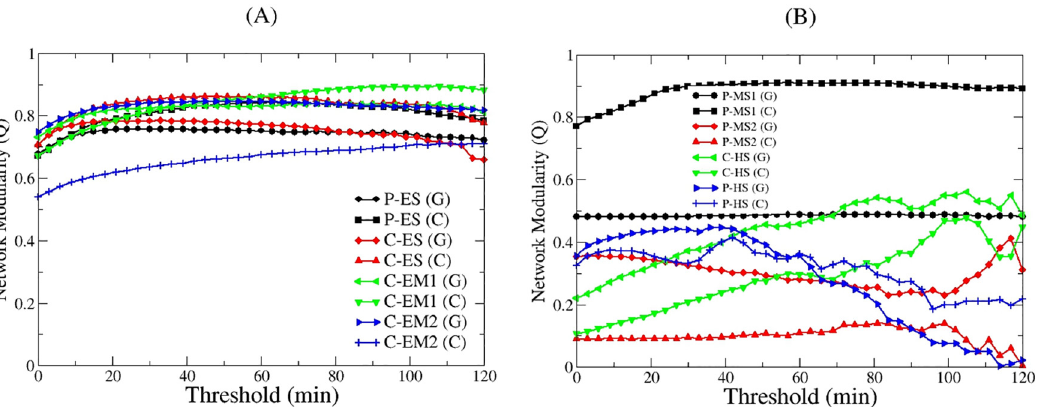
Fig 8. Network modularity versus threshold * . (A) Elementary and elementary-middle schools (B) Middle and high schools. * The contacts with total duration less than threshold are ignored. (G): grade-based modularity; (C): classroom-based modularity; C: Charter school; P: Public school; ES: Elementary school; EM: Elementary-middle school; MS: Middle school; HS: High